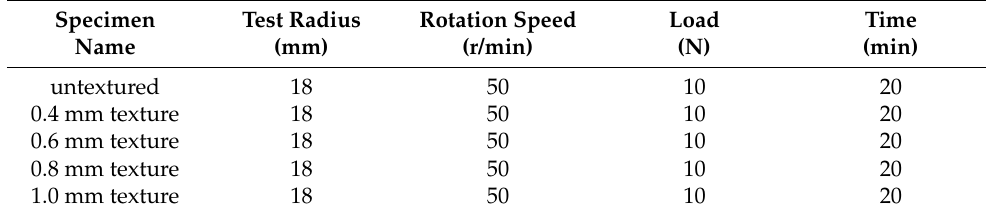
Table 4. Experimental